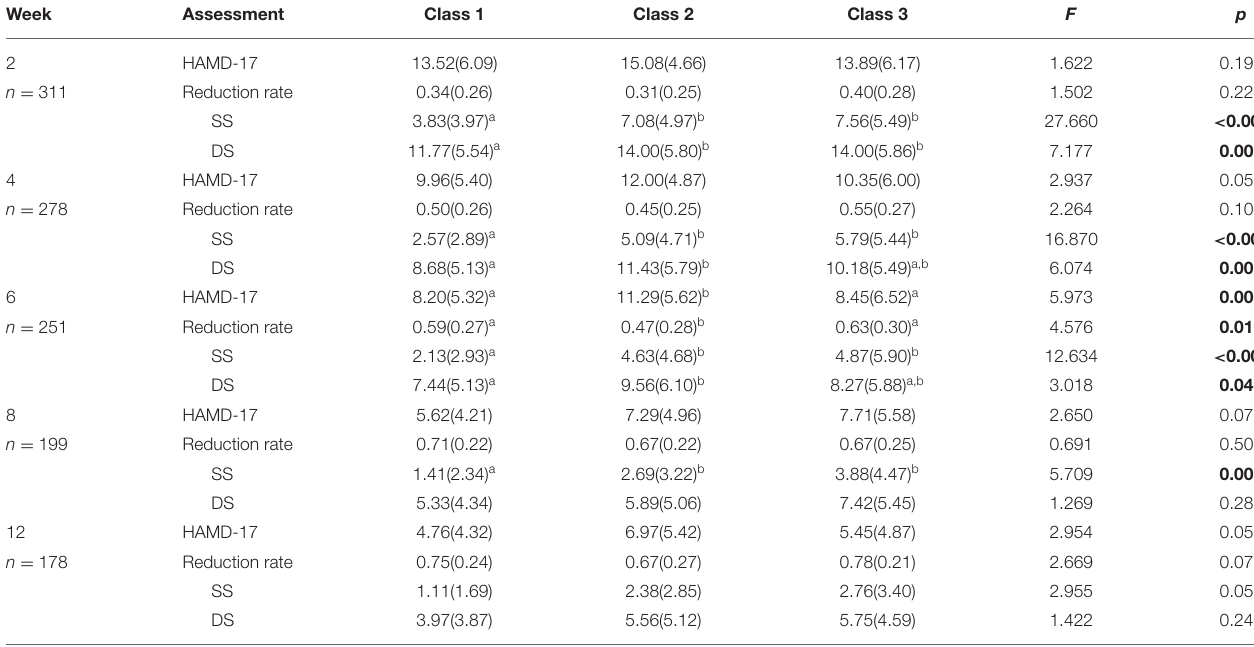
TABLE 4 | Longitudinal assessments among the three subtypes by